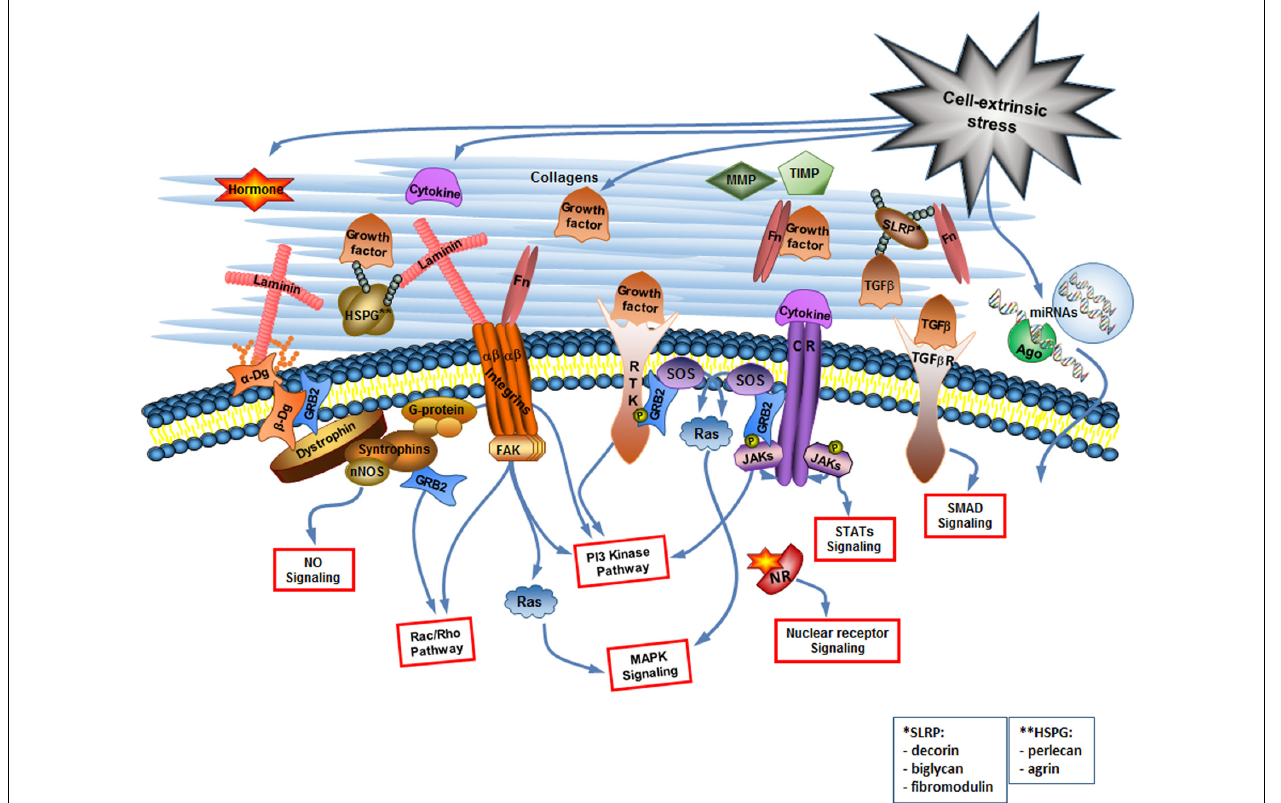
receptors and receptors for signaling molecules. Integrins and dystroglycan (Dg) are the ECM receptors.They do not only connect cell to its matrix but are also involved in the cell signaling. Multiple receptors for signaling molecules [including receptor tyrosine kinases (RTK), cytokine receptors (CR),TGF- β receptors, and nuclear receptors (NR)] transduce changes in the extracellular environment into the various signaling pathways inside the cell. Extracellular miRNAs can probably be taken up by the cell via yet unknown mechanism. NO, nitric oxide, Ago,